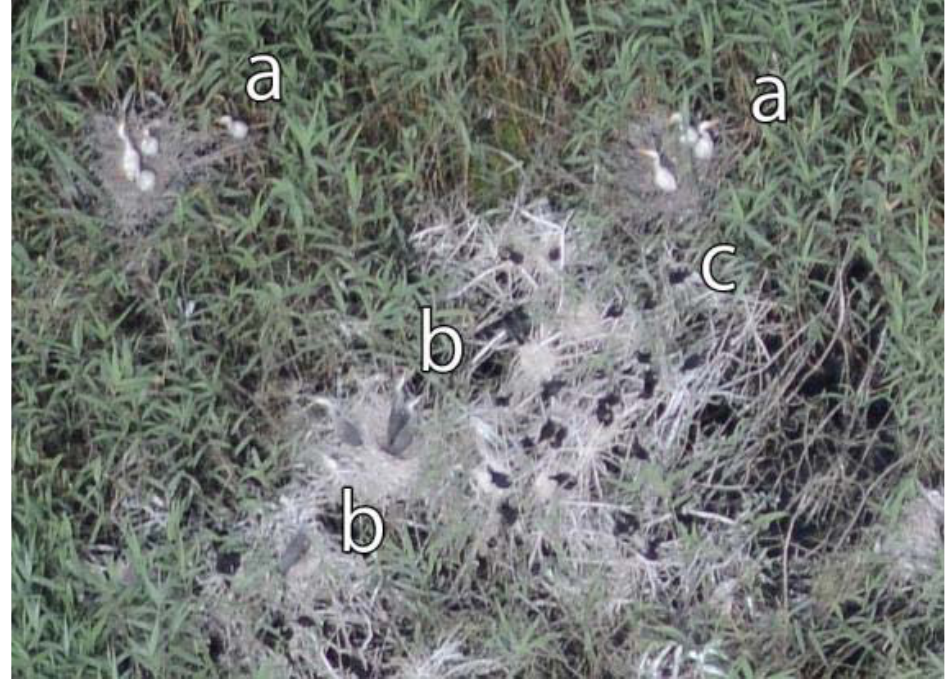
Figure 13. Detail of an oblique image. An oblique camera axis image with ( a ) Great White Egret nestlings, ( b ) Grey Heron nestlings, and ( c ) Pygmy Cormorant nestlings.